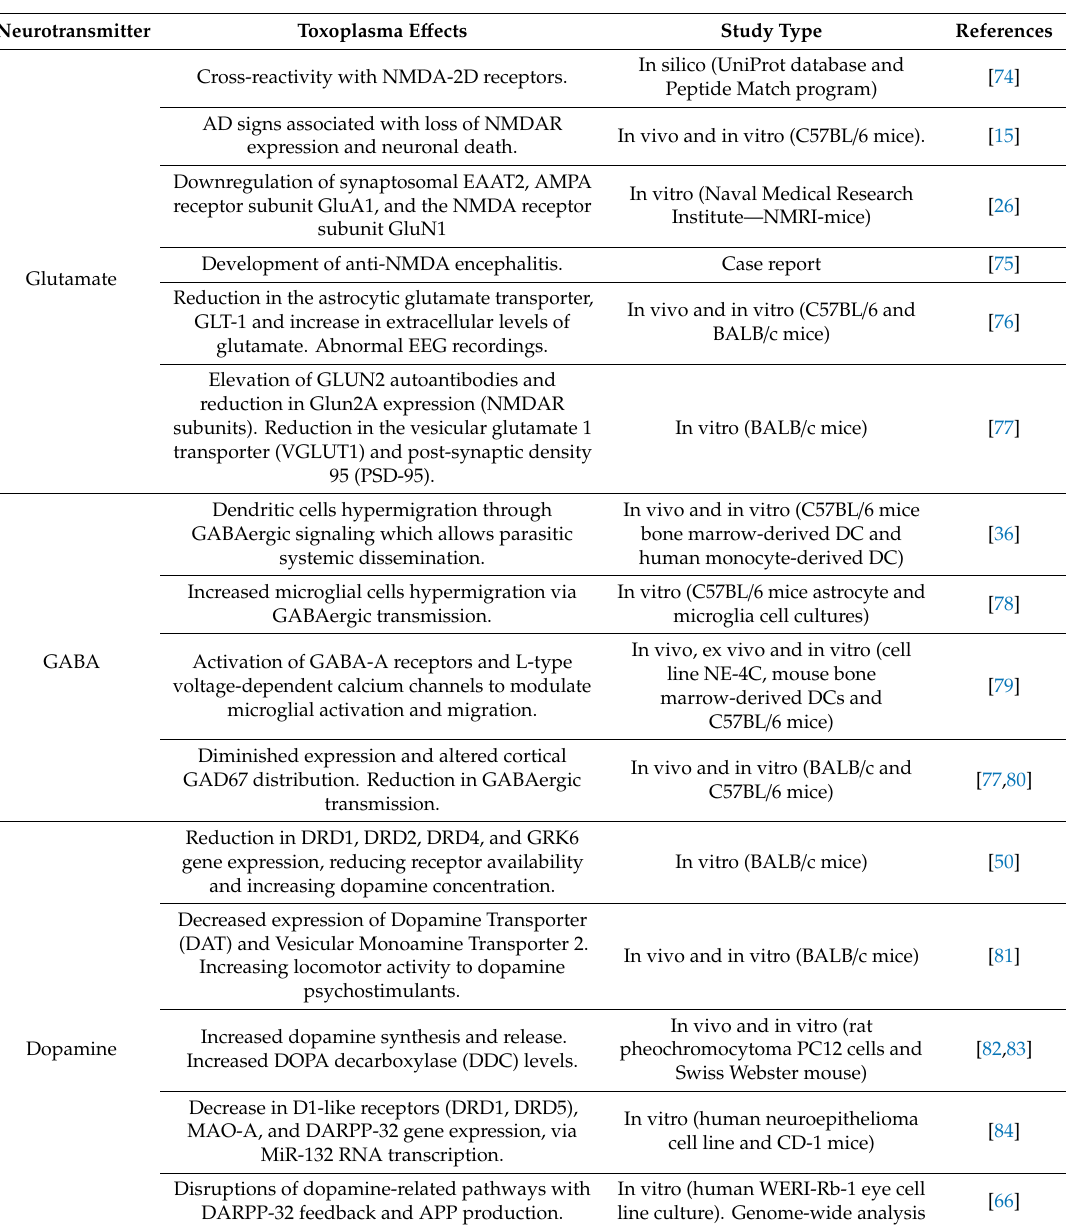
Table 1. Summary of the Toxoplasma gondii e ff ects on main neurotransmitter systems.